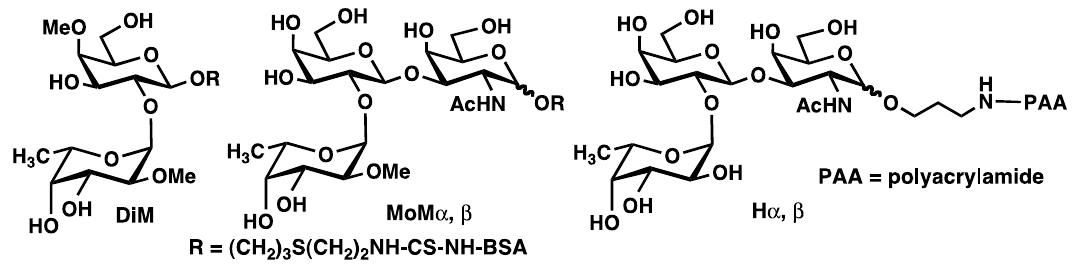
Figure 1. Structures of previously prepared DiM, MoM α , β and the human blood group antigen